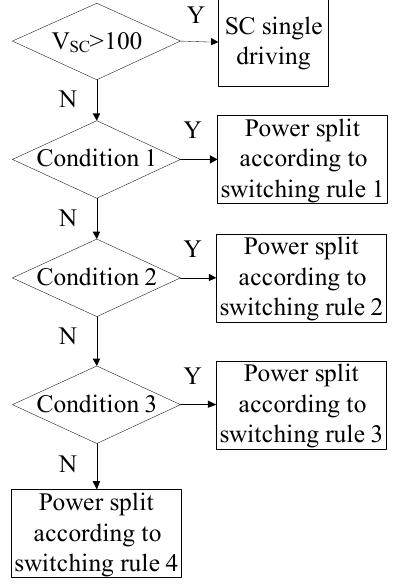
Figure 11. The flow-chart of the rule-based strategy.